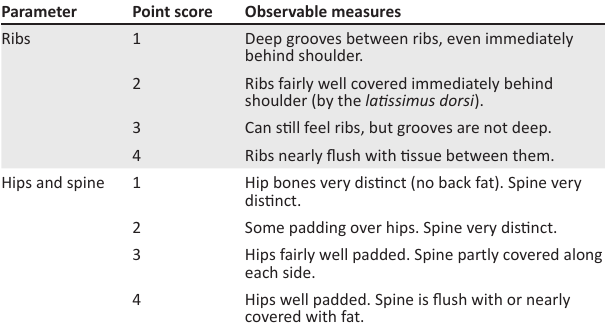
TABLE 1: Assessment of body condition criteria at bleeding using the rating system outlined below. Parameter